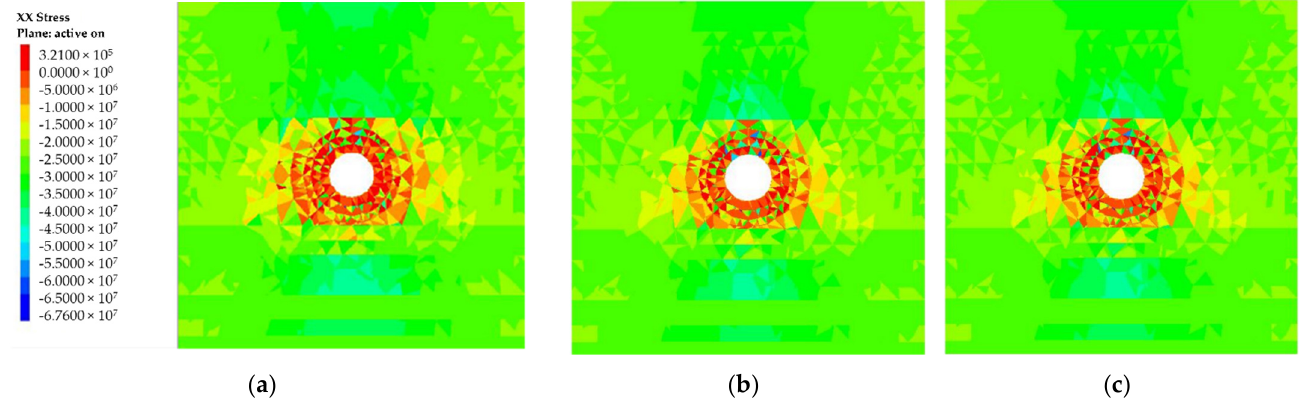
Figure 8. Horizontal stress distributions of the rock mass around the tunnel of the support face: ( a ) unsupported, ( b ) radial support, and ( c ) non-radial support. The displacement distributions of the surrounding rock are presented in Figures 9 and